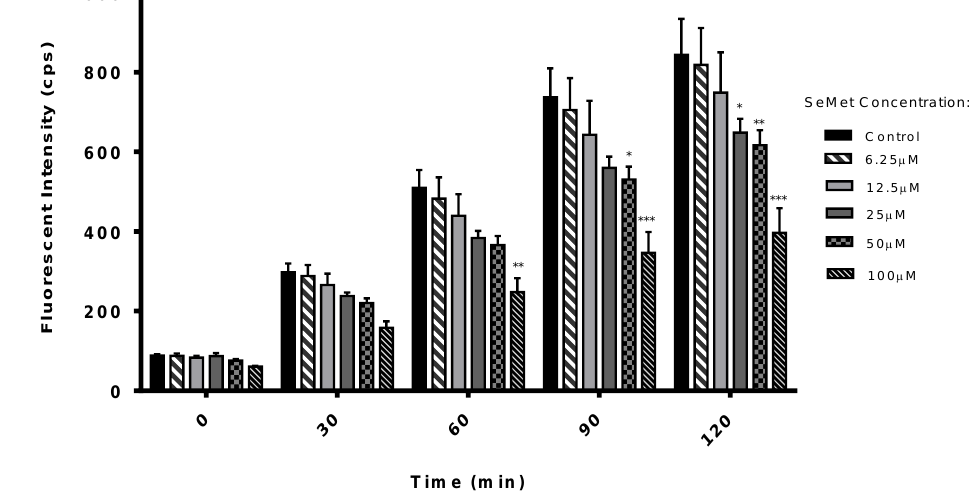
Figure 1. Effect of SeMet on inhibition of induction of ROS in Caco-2 cells by TBHP (100 μM). One- way ANOVA with Dunnett’s multiple comparison post-test, * p < 0.05, ** p < 0.01 and *** p < 0.001, compared to controls. Each value represents the mean ± SEM in triplicate ( n = 3), with 3 independent replicates.